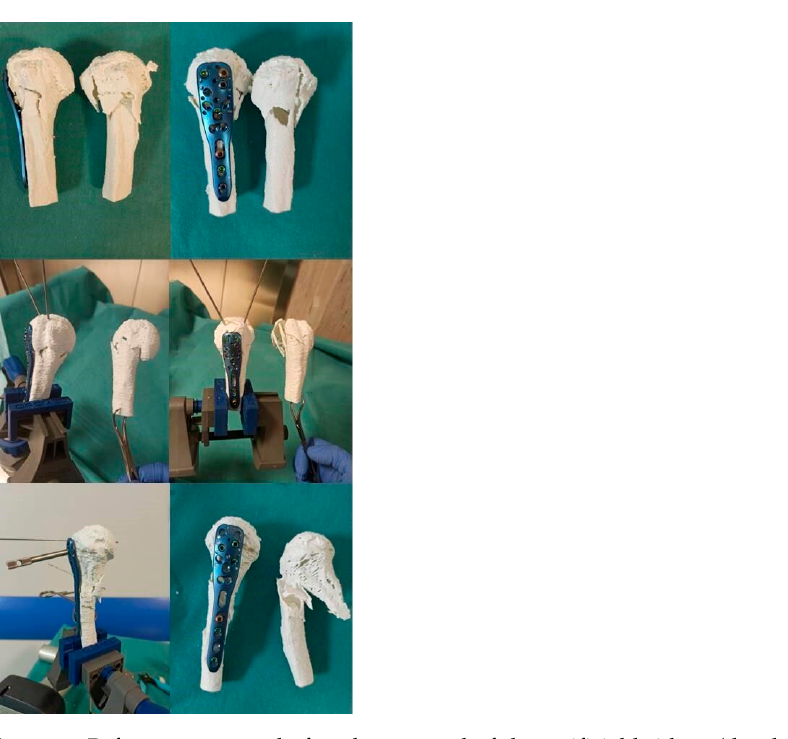
Figure 2. Before surgery and after the removal of the artificial bridges (that kept the fragments displaced), a simulation of the reduction and stabilisation of the fracture was performed, allowing the surgeon to plan the best position of the fragments and to choose the best-sized surgical hardware.